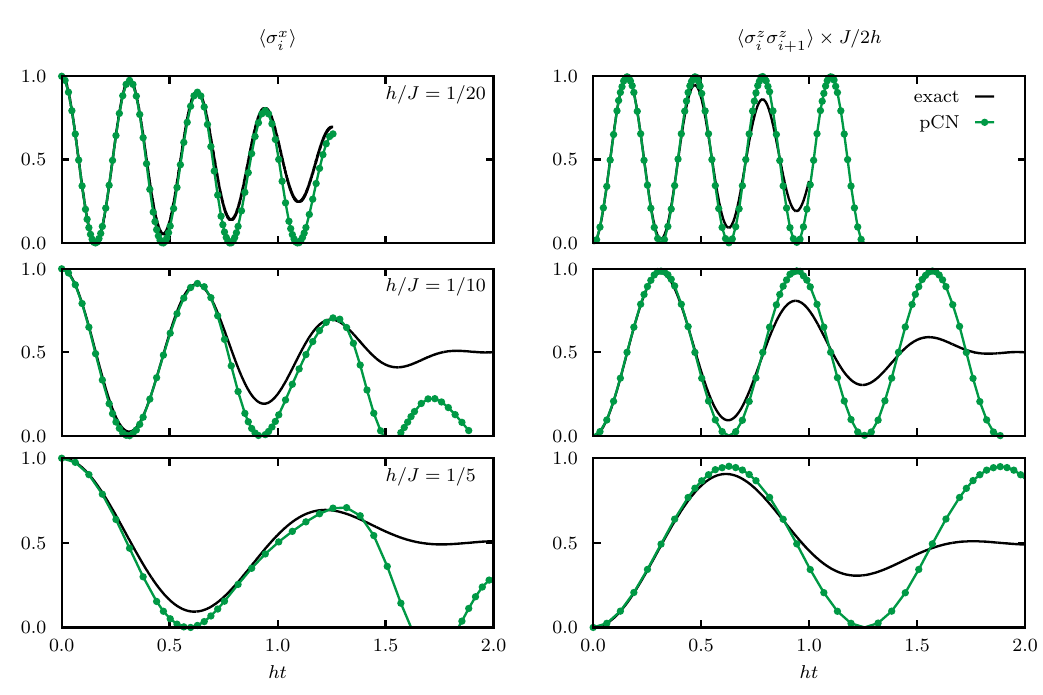
〉 and the right column shows spin-spin correlation i